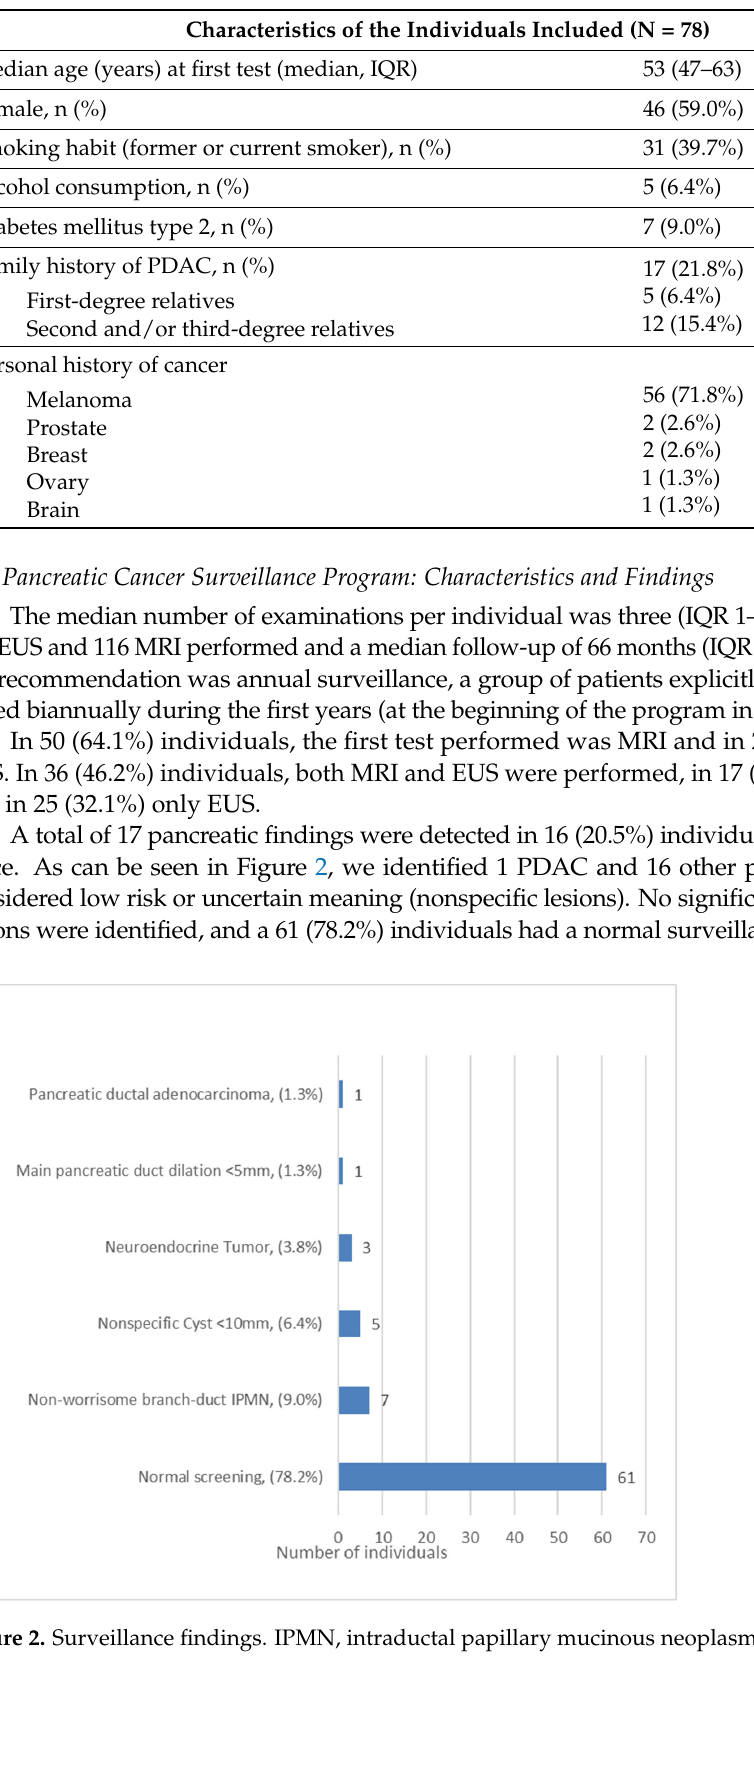
Table 1. Cohort baseline characteristics (N = 78). IQR, interquartile range; PDAC, pancreatic ductal adenocarcinoma.